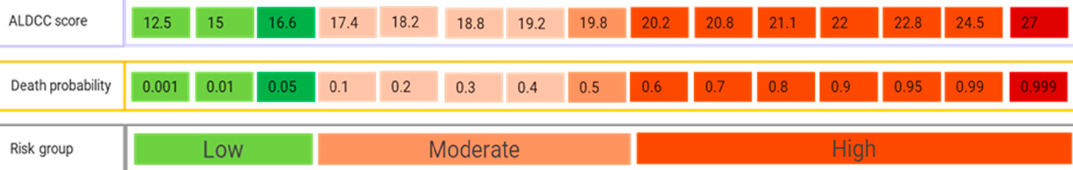
Figure 8. An example of nomogram-based ALDCC score to predict the probability of death of a patient from the test set (3 weeks before the actual outcome).